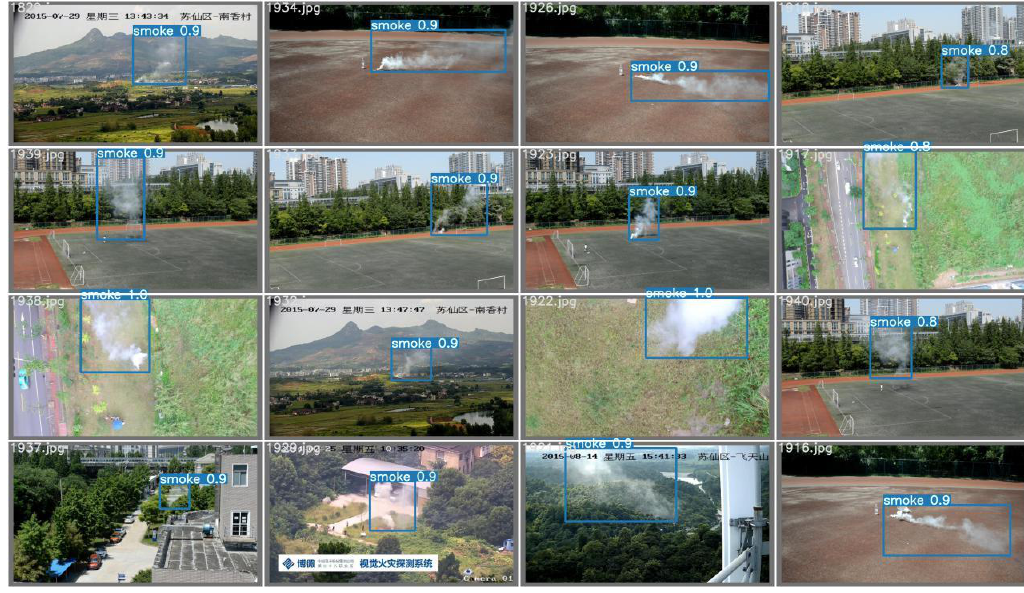
Figure 7. Detection results with the proposed model.